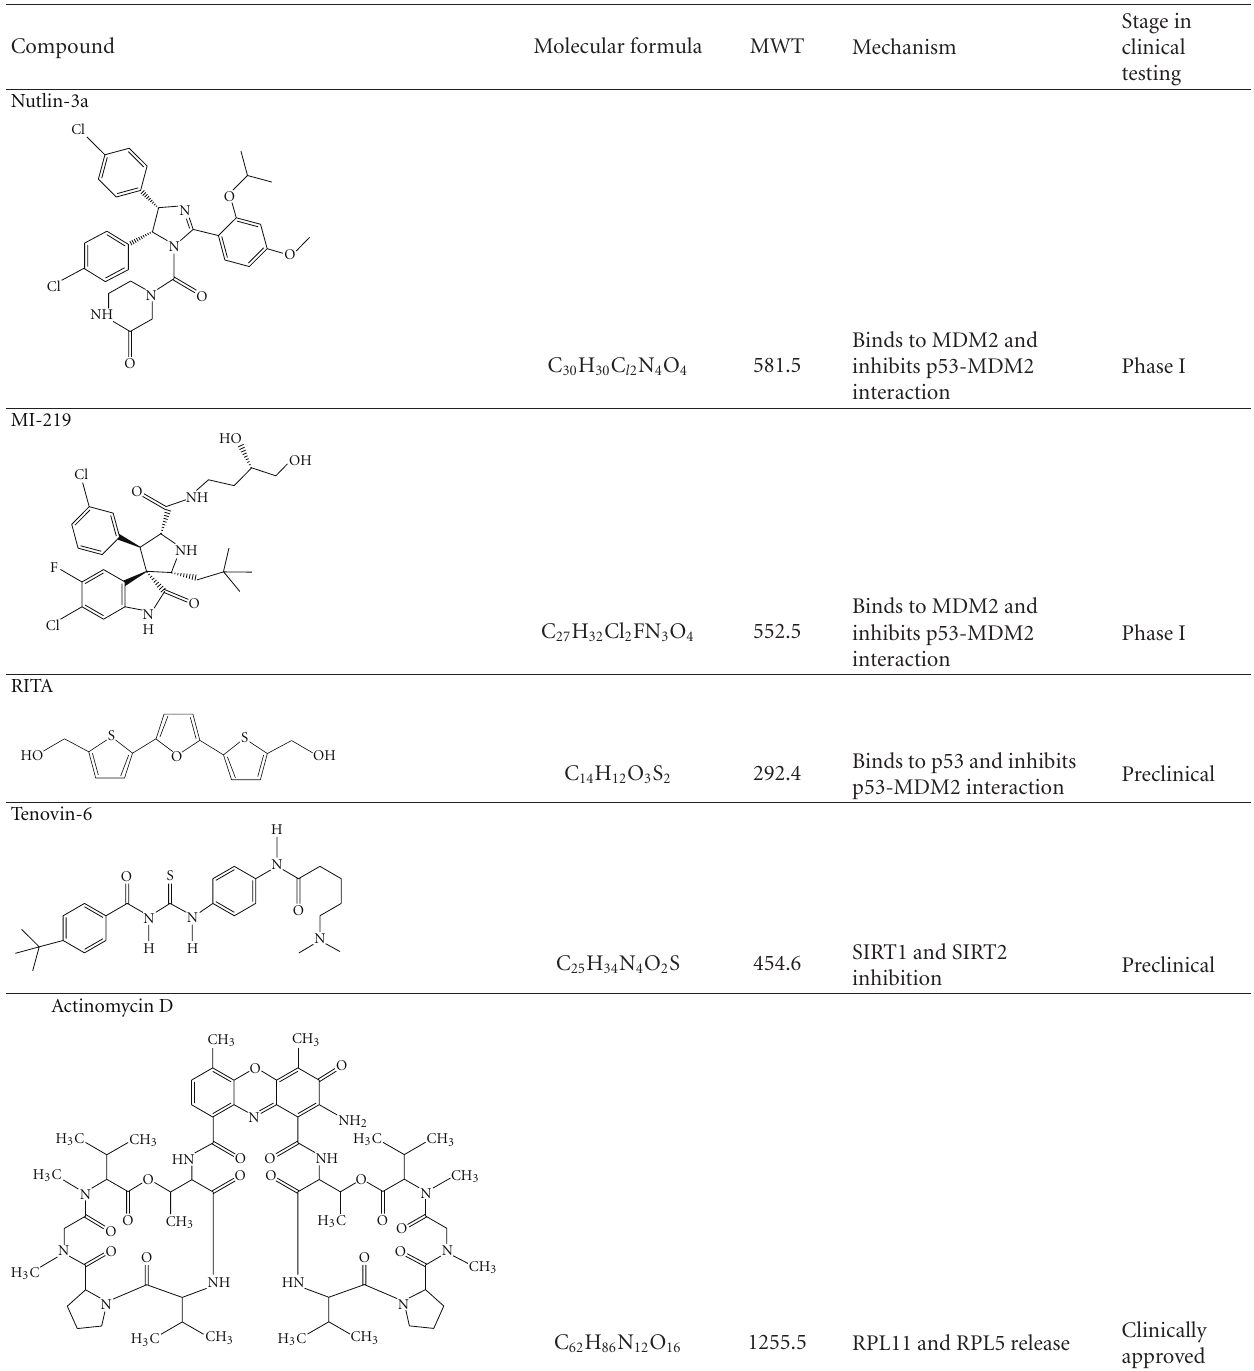
Table 5: Chemical structures and proposed mechanisms of small molecule p53